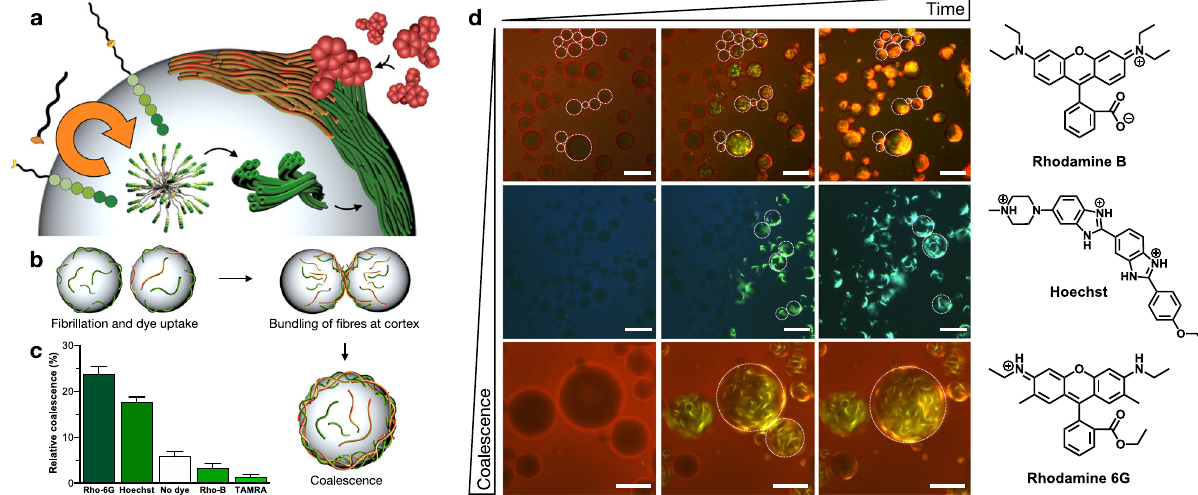
Fig. 3 Fibre-mediated uptake of external molecules and droplet coalescence. a Schematic showing fi bre-forming autocatalytic reaction in a w/o emulsion triggering the uptake of external dyes. Note that Span 80 has not been drawn for clarity. b Schematic showing dye-mediated coalescence of adjacent droplets induced by con fi ned fi brillation. c Relative coalescence of droplets undergoing fusion in the presence of external dyes ( n ≥ 65, see Supplementary Fig. 10). These values are calculated as the relative increase (%) in average droplet diameter after the addition of T 8 (see Supporting Information). d Fluorescence micrographs showing coalescence of adjacent droplets in the presence of different external dyes (see structures on the right). Contoured droplets are representative positive/negative coalescence examples. Scale bars = 80 µ m. All experiments contain ThT at 5 µ